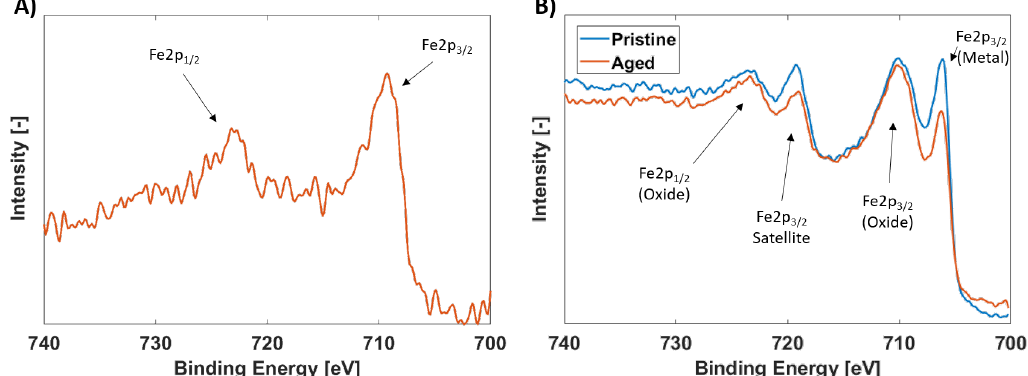
Figure 8. XPS analysis results of the Fe peak: ( A ) from the roots of the CNTs remaining on the Cu superstrate after delamination; and ( B ) from the Si substrate after delamination before and after thermal